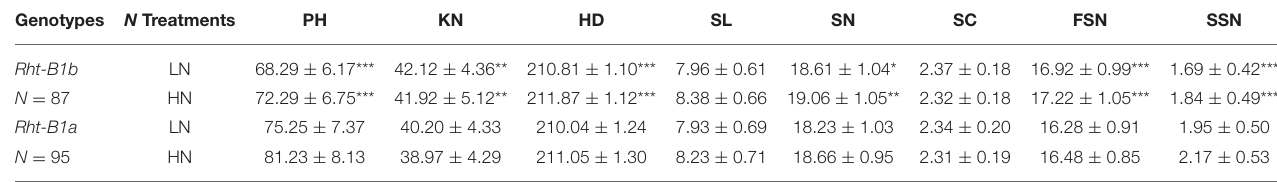
TABLE 4 | Validation of the putative pleiotropy of Rht-B1b on spike characteristics and kernel number. Genotypes N